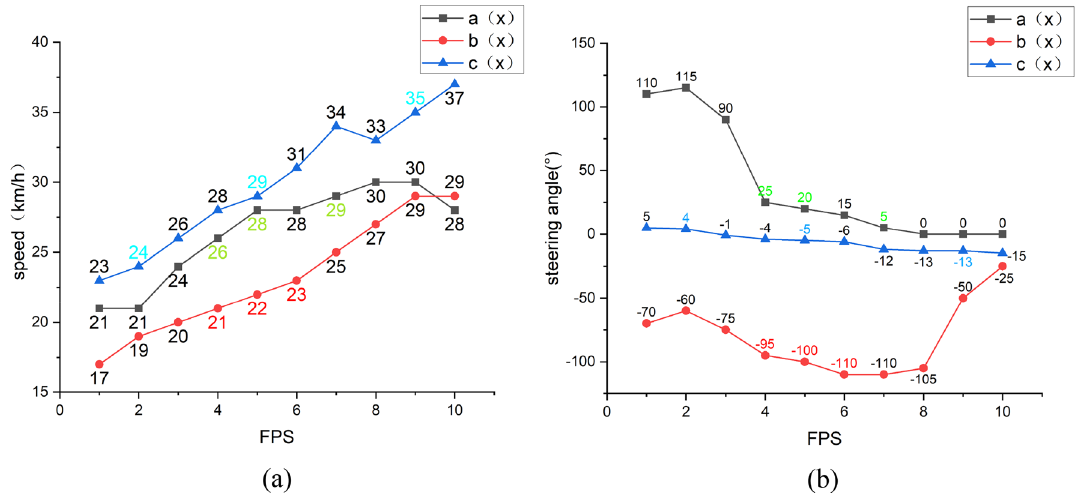
Figure 13. Vehicle driving state data map, where ( a ) is the vehicle speed data in three scenarios; ( b ) is the steering wheel angle data in three scenarios, a(x), b(x), c(x)in the two images corresponding to the three driving scenes of a, b, and c in Fig. 14 respectively. The three points with different colors on each broken line correspond to the three frames of images selected in Fig. driving at 0°. In this process, the broken line a(x) in Fig. 13a also shows that the speed of the vehicle in the open road on the right turn has risen from 26 to 30 km/h. So at this time, the driver’s attention area focuses on the right turning road. The visualized images in the group "a" in Fig. 14 also shows that the attention area of the driver gradually shifts from the pedestrian on the left side of a(1) to the right area of a(3). Finally, transfer the attention area to the right turn road that is about to enter.